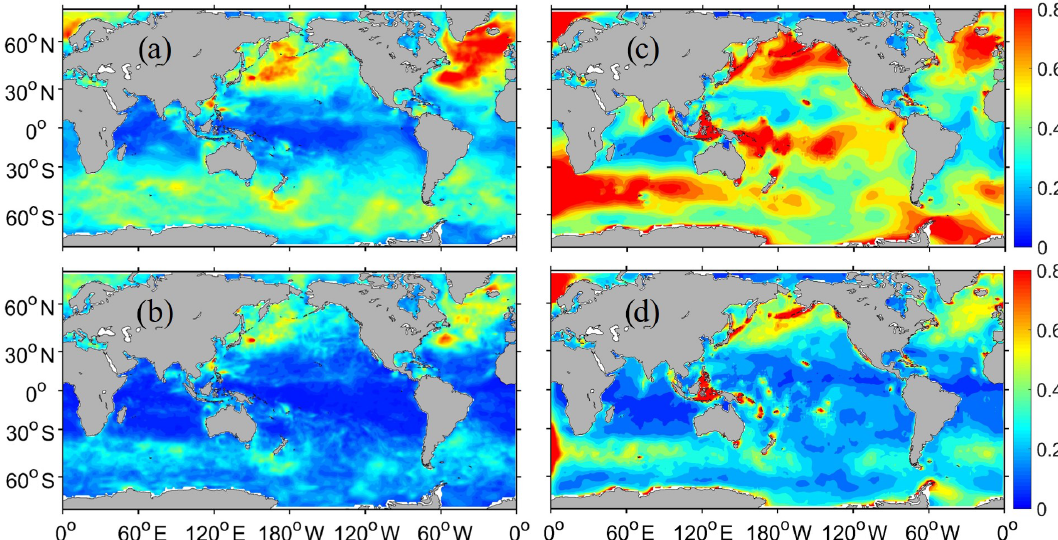
Figure 5. Distributions of SWH RMSEs caused by wind forcing (a, b) from perfect twin experiment and model bias (c, d) from biased twin experiment in the model control run (a, c) and assimilations with “observed” data with three satellites (b, d) averaged globally over the last 30d during the assimilation